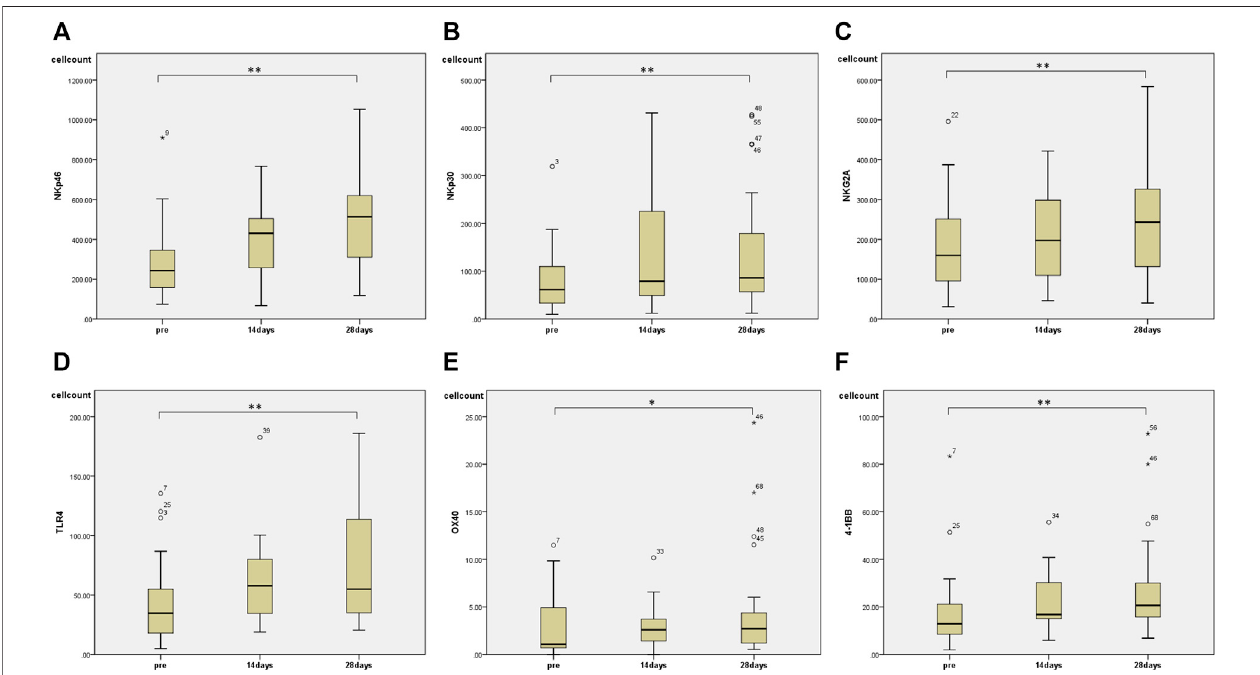
FIGURE 3 | The effects of HET and KKT on PBMC subsets. The 28 days administration of HET and KKT resulted in a signi fi cant increase in the (A) activator receptors NKp46 (B) NKp30, and (C) suppressing receptor NKG2A. Expression of other cell surface markers including (D) TLR4; (E) OX40, and (F) 4-1BB also signi fi cantly increased. * p < 0.05; ** p <